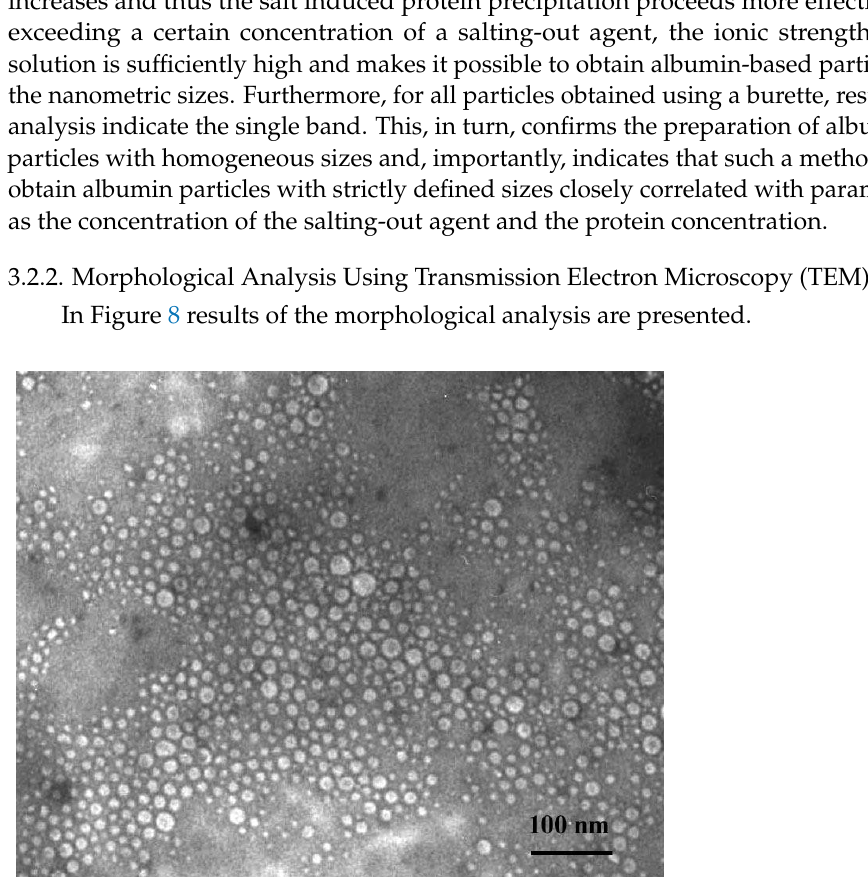
Figure 8. TEM Microphotograph of obtained albumin spheres (potassium phosphate concentration: Albumin concentration ratio—1:2 [mol/L: g/L]).